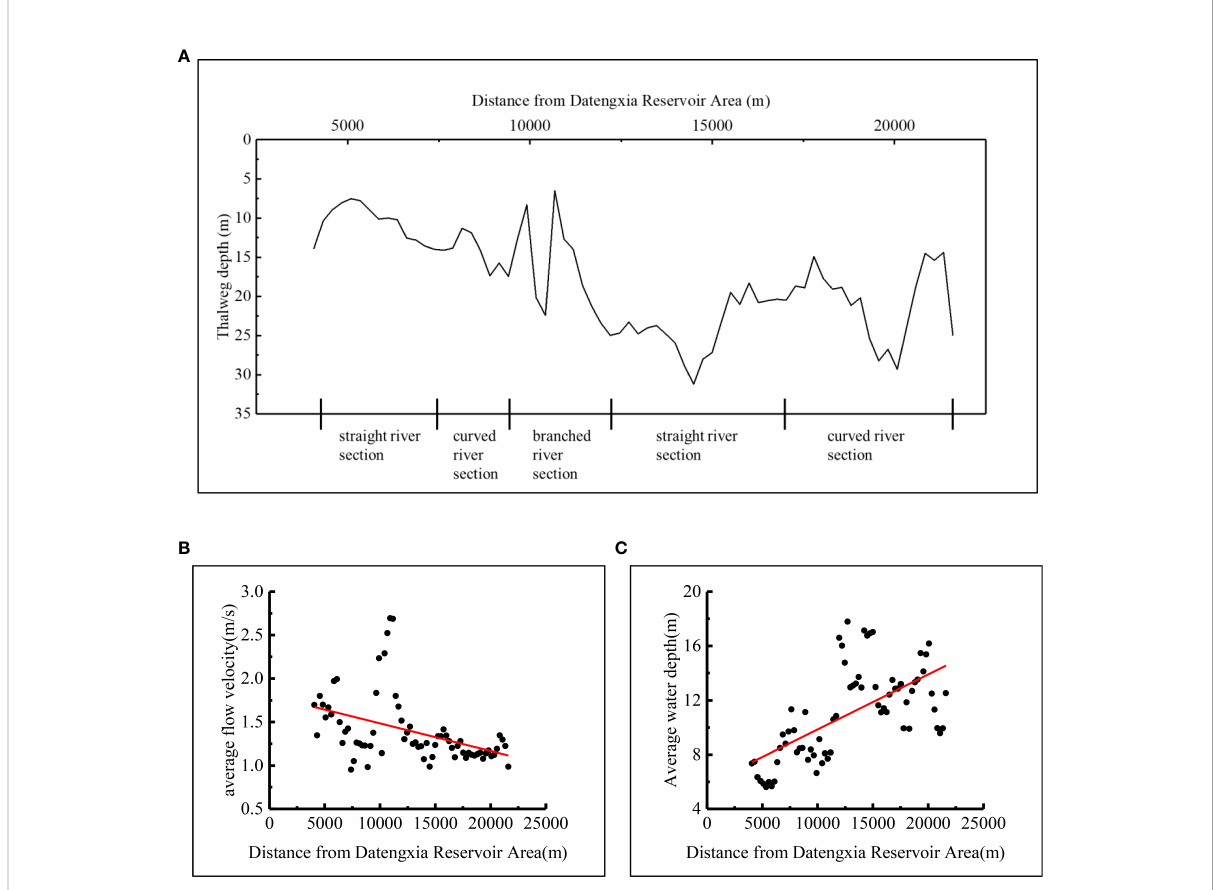
FIGURE 6 Flow characteristics of the river section selected for this study. The mileage number of the Datengxia Dam is 0 river kilometer. (A) Thalweg depth; (B) average fl ow velocity at cross sections; (C) average water depth at cross